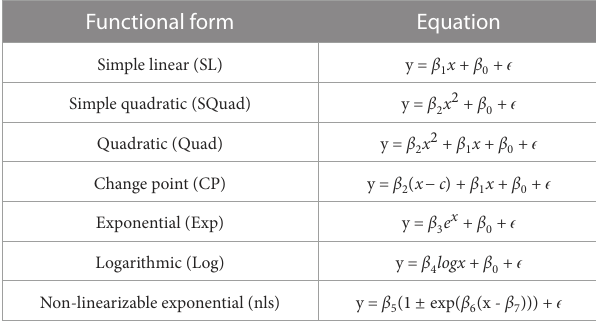
TABLE2 Thesevenfunctionalformsandthecorrespondingmathematical equationsusedinnetSEM. Functional